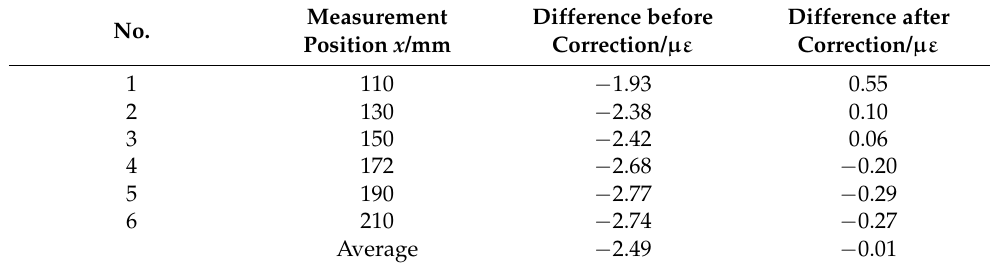
Table 4. Strain difference before and after correction with a load of 100 N.